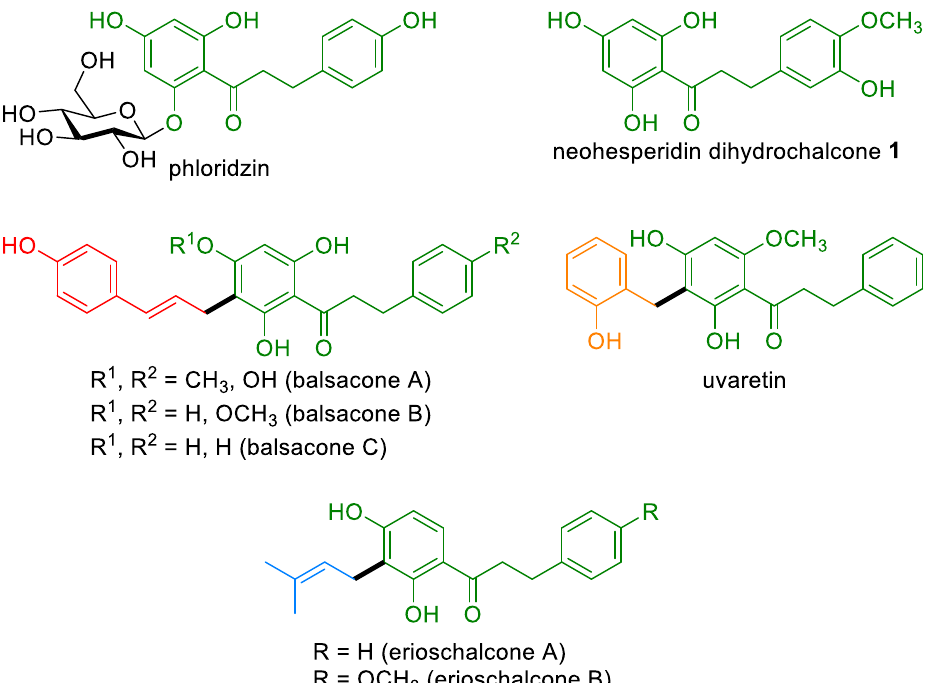
Figure 1. Structure of various dihydrochalcones, including the aglycone moiety of neohesperidin dihydrochalcone ( 1 ).